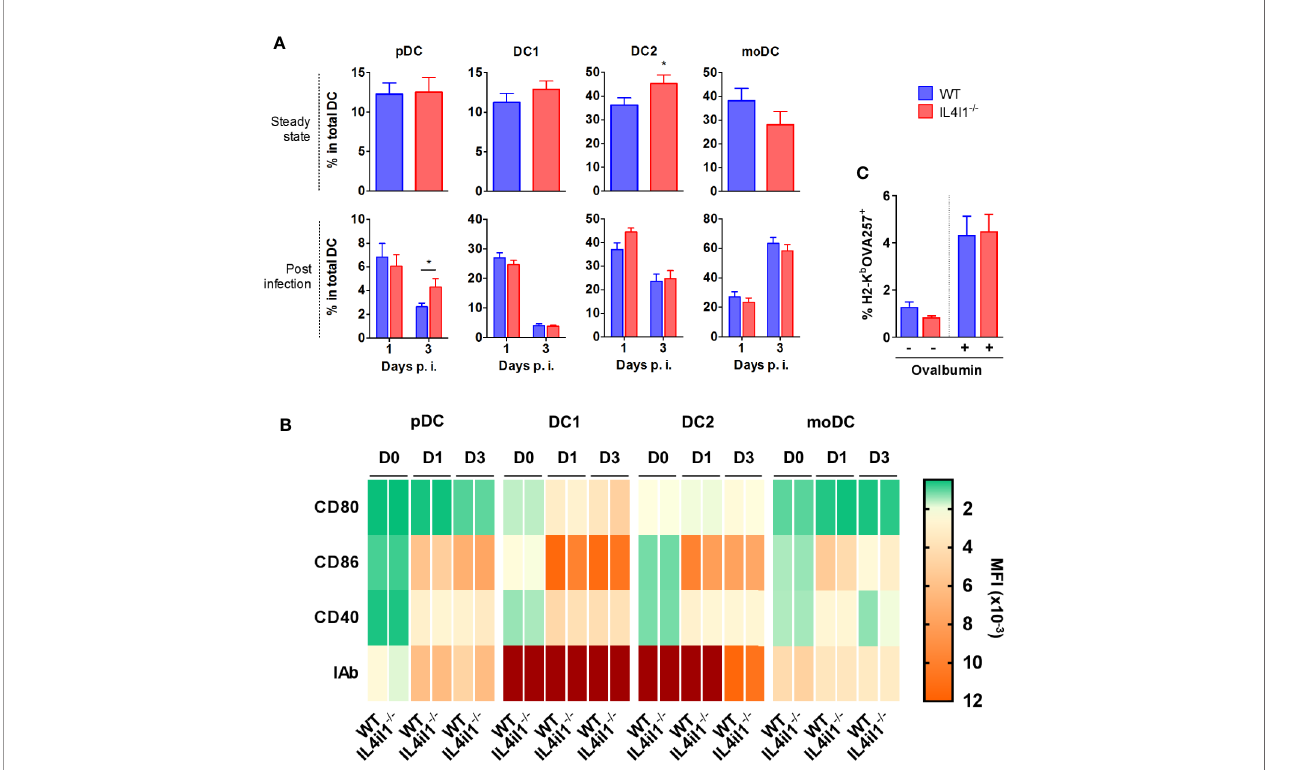
FIGURE 4 | Repartition, maturation phenotype, and antigen-presenting capacity of splenic DC populations from IL4I1 -/- and WT mice (A) . DC subsets from WT (blue) and IL4I1 -/- mice (red) were analyzed by fl ow cytometry, according to the gating strategy presented in Figures S2 and S4 , at steady state and days 1 and 3 p.i., respectively. The percentage of plasmacytoid DCs (pDC), conventional type 1 (DC1) and type 2 (DC2) DCs, and monocyte-derived DCs (moDC) was calculated in the total DC Boolean gate (B) . Mean fl uorescence intensity of CD80, CD86, CD40, and IA b on each subset at steady state (D0) and days 1 (D1) and 3 (D3) p.i. are presented as a heat map. The corresponding values are plotted in Figure S3 (D0) and S5 (D1 and D3). Mean (± SEM where applicable) from six (steady state) and three experiments (p.i.) with two to three mice per group (C) . Total DCs enriched by negative magnetic cell sorting were cultured in the presence of ovalbumin 2 h before measuring presentation of the OVA257 peptide by fl ow cytometry using an antibody speci fi c for H2-K b OVA257 complexes. Mean ± SEM from two cell sorting experiments with four independent tests per condition. * p < 0.05 Figure 3 ) is estimated to be between 1:4x10 3 and 1:8x10 3 (26), thus involving much more stringent clonal competition.